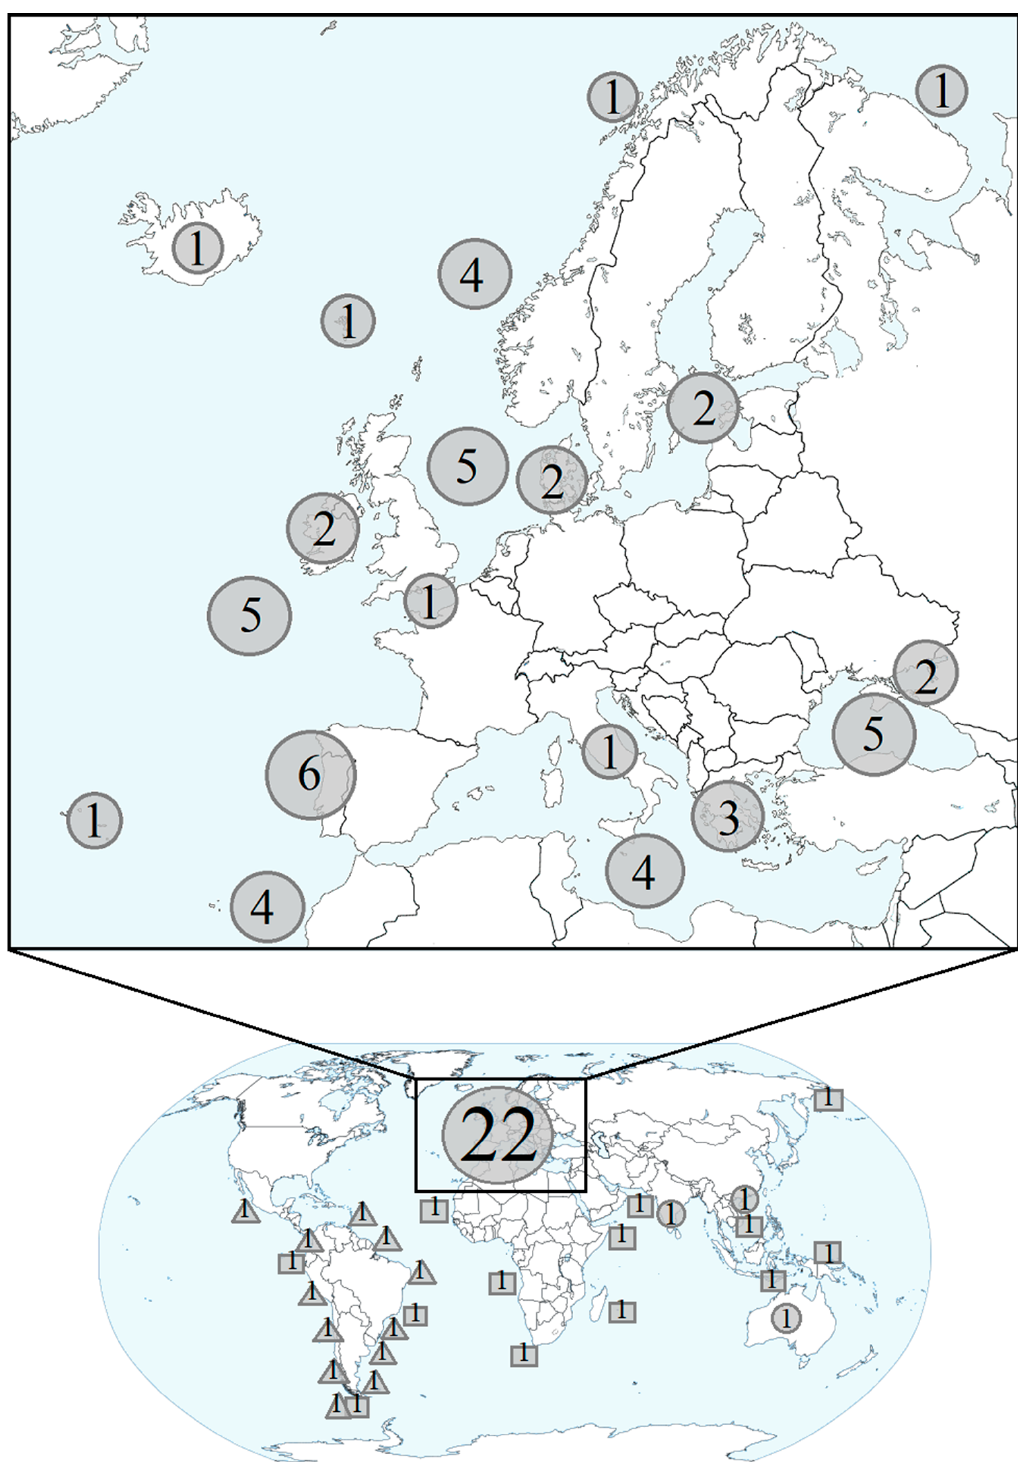
Figure 2. Geographic locations of existing studies for combined offshore wind and wave energy site selection (the areas represented in the rectangle and the triangle are related to two studies with considerable numbers of studied sites around the world). Note that a study performed for all offshore areas around the world [41] is not shown in this